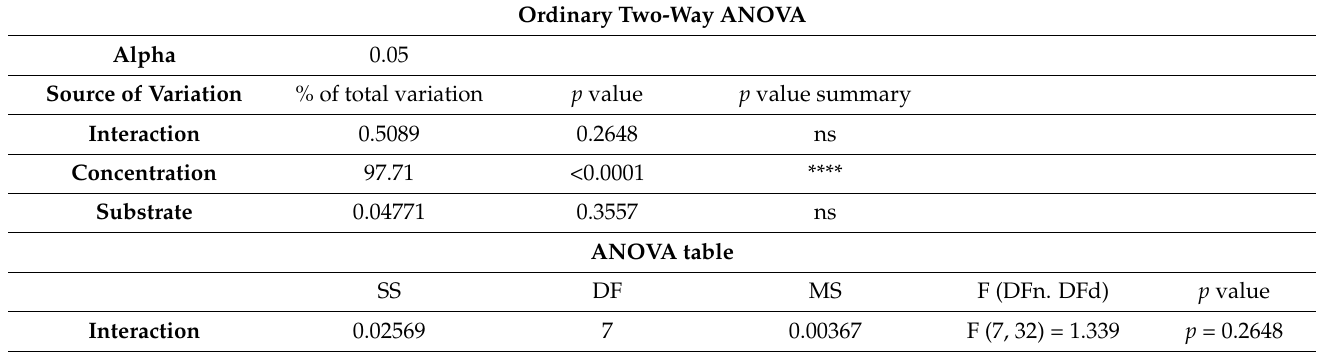
Table A3. Ordinary two-way oviposition ANOVA analysis and Tukey’s multiple comparisons test to evaluate the effect of polymer type and concentration on T/C in the groups CL-HEC2-30